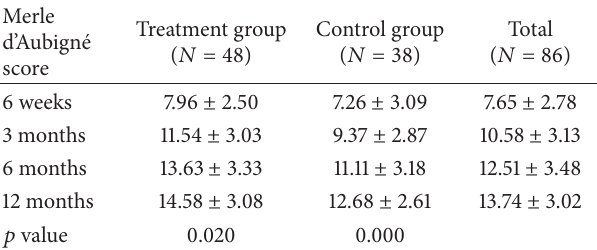
Table 1: Comparisons of the mean Merle d’Aubign´e scores at each time point.